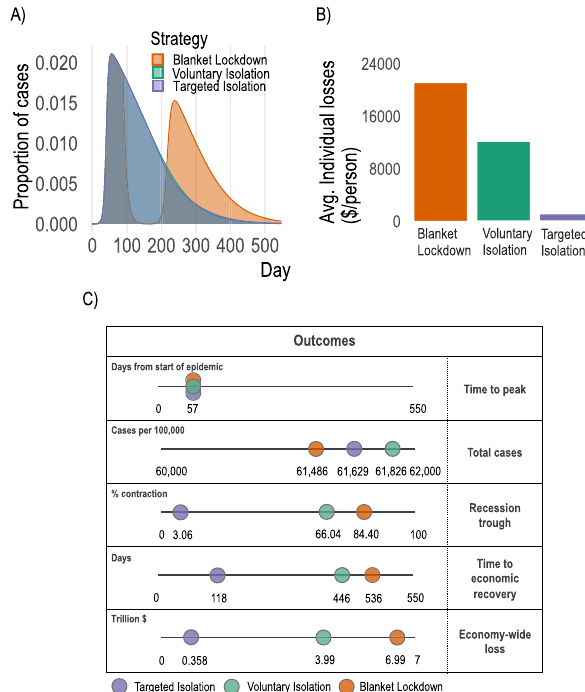
Fig. 2 Disease dynamics and economic outcomes under voluntary isolation, blanket lockdown, and targeted isolation. A Proportion of population infected over time under each strategy. Voluntary isolation and targeted isolation curves are almost-entirely overlapping, indicating nearly- identical disease dynamics. B Individual losses incurred under each strategy (targeted isolation averts 95% of voluntary isolation individual economic losses). C Key aggregate disease and economy outcomes under each strategy. See SI 2.5 for comparison with a “ no control ”